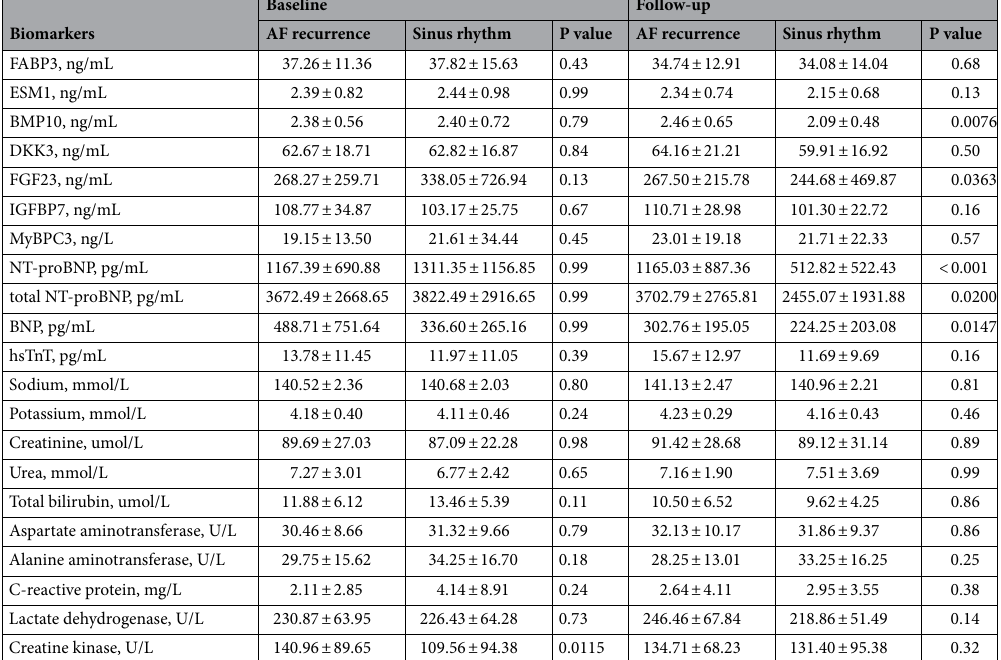
Table 2. Absolute biomarker levels at baseline and follow-up stratified by rhythm status at follow-up. FABP3 fatty acid binding protein 3, ESM1 endothelial cell-specific molecule-1, BMP10 bone morphogenetic protein 10, DKK3 , dickkopf related protein-3, FGF23 fibroblast growth factor 23, IGFBP7 insulin growth factor binding protein-7, MyBPC3 myosin-binding protein C, NT-proBNP N-terminal pro-B-type natriuretic peptide, BNP brain natriuretic peptide, hsTnT high-sensitive troponin T. Values are mean ± standard deviation. P value compares biomarkers levels between patient with AF recurrence and patients with sinus rhythm and